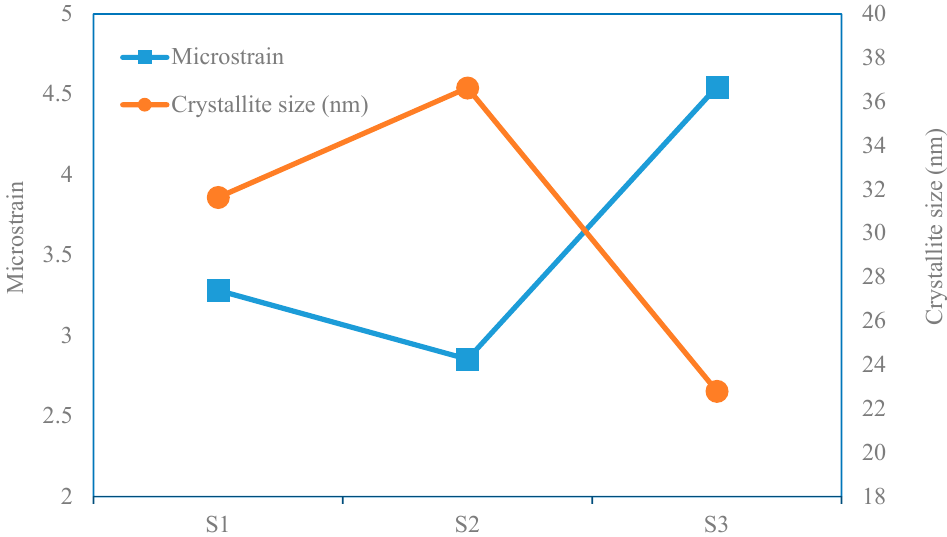
Figure 7. Microstrain and crystallite size for the produced bulk composites by each